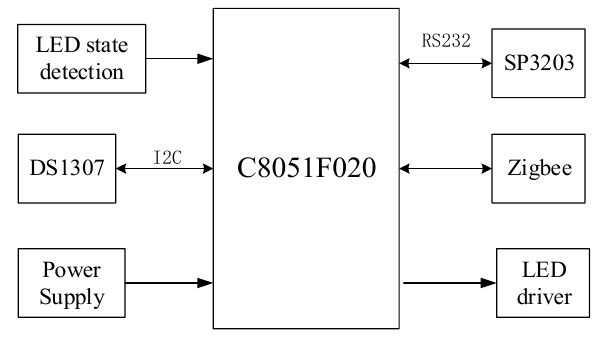
Fig. 2. Controller Structure